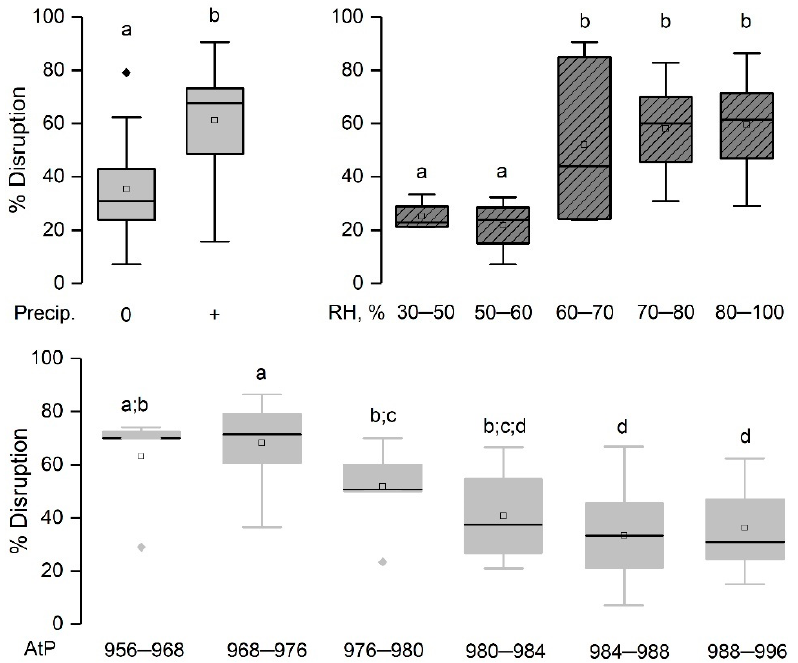
Figure 4. Influence of precipitation, RH and atmospheric pressure (AtP) on pollen disruption. The data was sectioned by the presence or absence of rainfall and by RH and AtP as mentioned. The different letters within the graphs indicate the statistical significance at 5% ( p < 0.05) among homogeneous subsets. Table 3. Own values and proportion of variance explained by